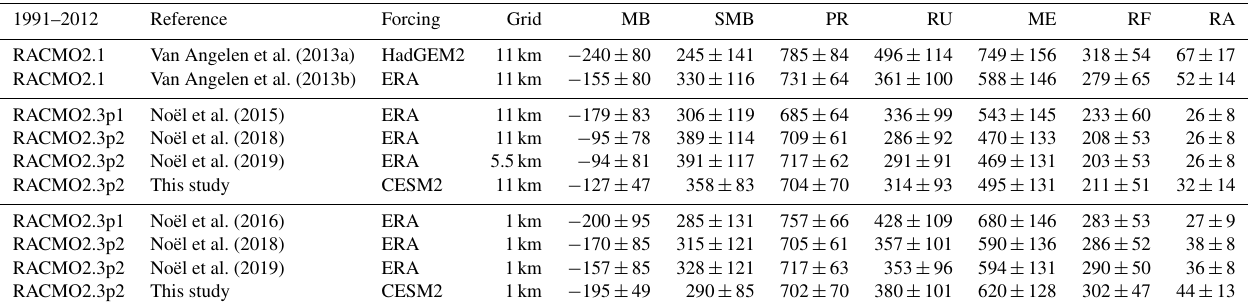
Table 2. Annual mean SMB and components integrated over the GrIS (Gtyr − 1 ) for the period 1991–2012 from an ensemble of RACMO2 simulations using various spatial resolutions and lateral forcing. SMB components include total precipitation (PR), runoff (RU), melt (ME), refreezing (RF) and rainfall (RA). The uncertainty range corresponds to 1 standard deviation around the mean. Here mass balance of the GrIS (MB) is estimated as GrIS-integrated SMB minus glacial discharge for the period 1991–2012 (485Gtyr − 1 ) (Mouginot et al.,